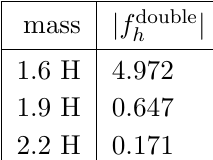
Table 3 . NG mediated by h via double exchange diagram in e(cid:11)ective Goldstone description.